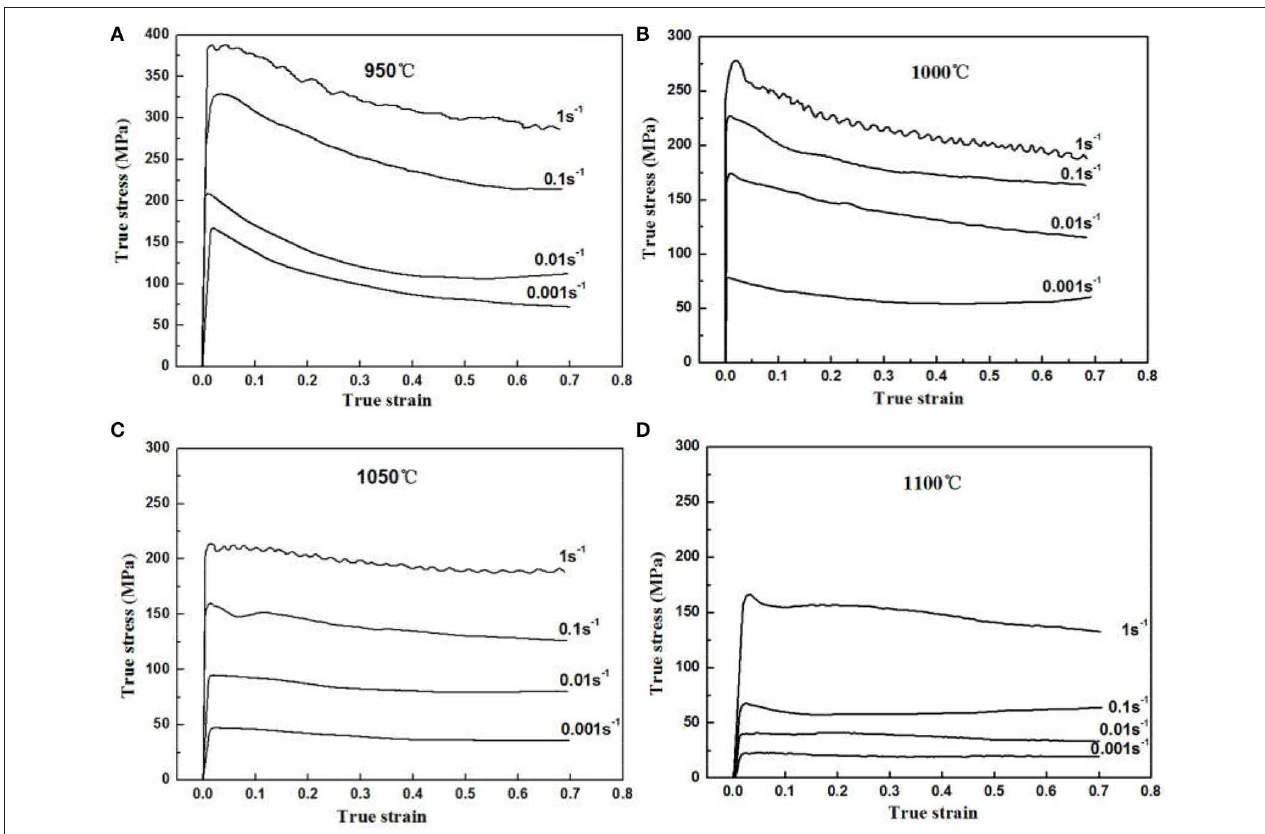
FIGURE 3 | The flow true stress-strain curves at various isothermal compression deformation conditions for the Ti-25.5Al-13.5Nb-2.8Mo-1.8Fe alloy: (A) 950; (B) 1,000; (C) 1,050; and (D) 1,100 ◦